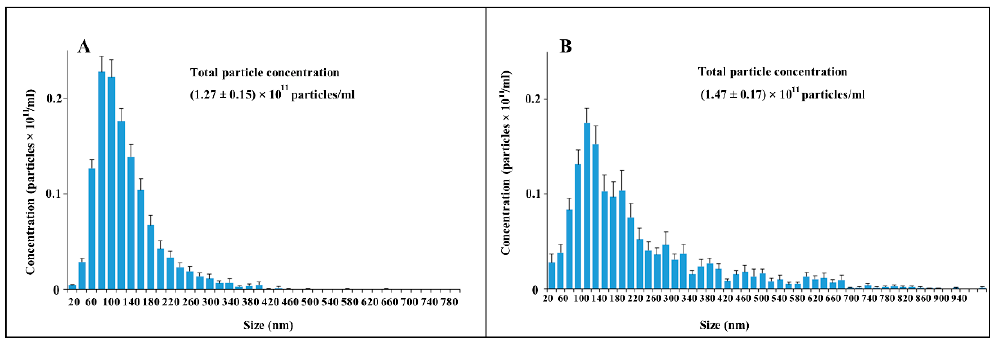
Figure 5. EV characterization by NTA analysis obtained in a sample either after 108,000 × g centrifugation (exosomes, ( A ), camera gain = 500; histogram values range: 185–1885, n =12), or ectosomes ( B ) obtained after centrifugation at 10,000 × g of cultivation medium ( n =12), camera gain = 225; histogram values range: 65–1560. NTA analysis represents data of mean values with standard error of mean.